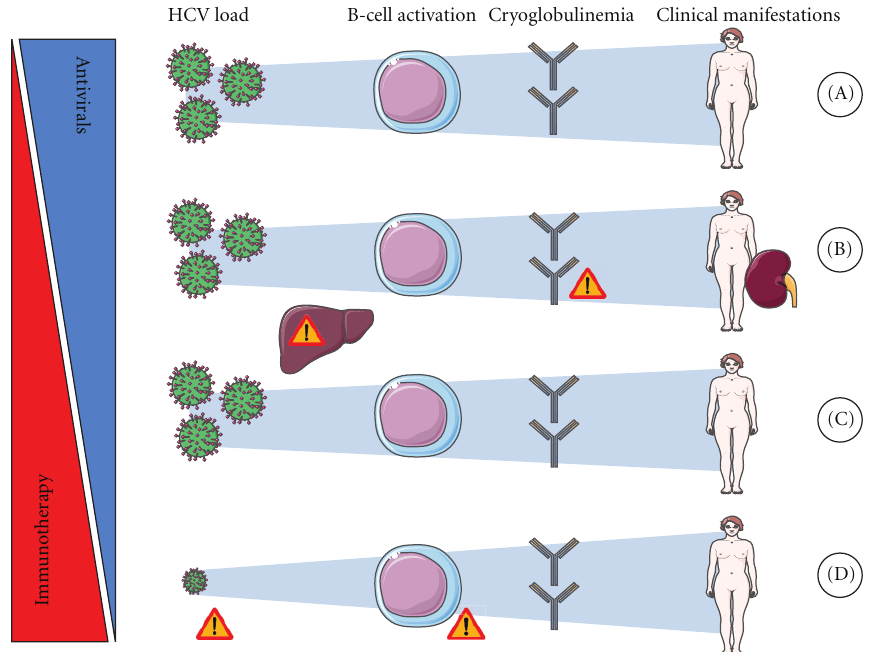
Figure 1: Immunotherapy to manage HCV-induced vasculitis. (A) Antiviral regimen, ideally a combination of interferon plus ribavirin, is the first-line treatment for HCV-induced cryoglobulinaemic vasculitis (CV) when the severity of its manifestations is mild-to-moderate. In addition, short-term low-dose corticotherapy may sometimes be used initially. (B) In cases of severe or life-threatening manifestations (i.e., severe renal involvement), immunotherapy must be initiated immediately. Rituximab has become a preferred choice but, as with other immunosuppressive drugs, careful monitoring of viral load and hepatic functions is necessary. Worsening of vasculitis has been reported in patients just after administration of rituximab, especially in those with serious cryocrit levels, thus, in these patients, corticosteroids and/or plasmapheresis may be initiated before B-cell depletion. An antiviral regimen is initiated either simultaneously or secondarily/sequentially in these patients. (C) When an antiviral regimen is contraindicated, poorly tolerated, or fails to induce a sustained viral remission, immunotherapy is also initiated. Corticosteroids should be avoided when possible. Careful monitoring of viral load/hepatic function is necessary. A prolonged antiviral regimen may be considered when clinical and biological manifestations of MC show an improvement under this regimen in spite of the absence of viral remission. (D) In cases where CV is still active in spite of obtaining a sustained viral response, B-cell malignancy and low-level viremia should be ruled out before considering that the vasculitis is autonomous and before initiating